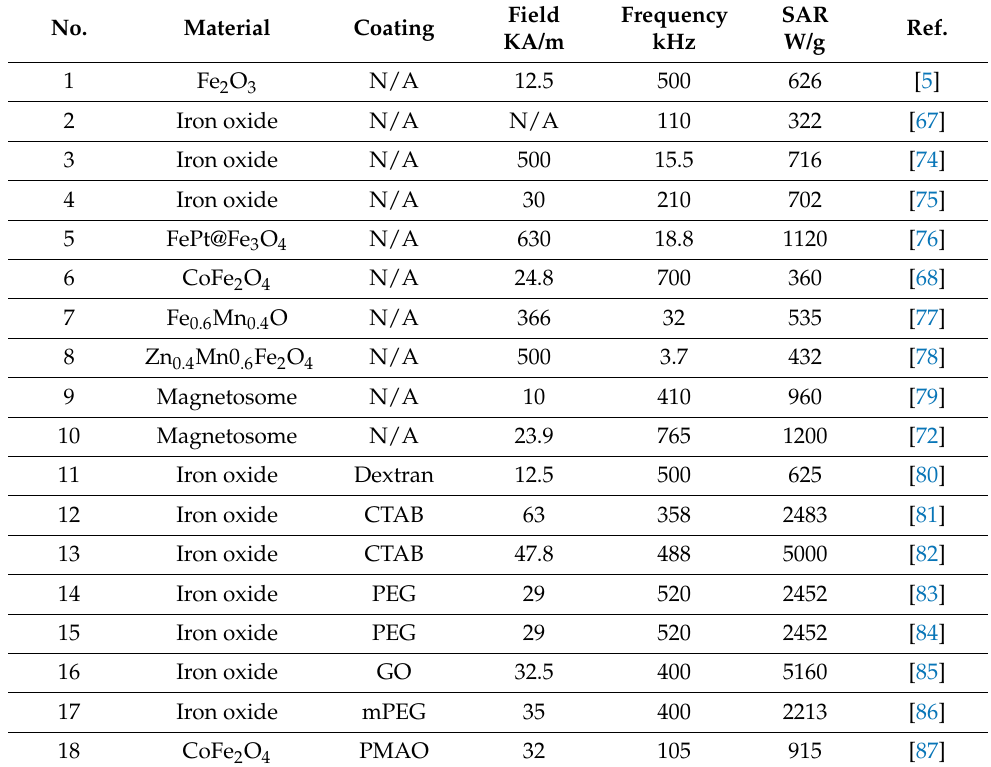
Table 1. SAR values for MNPs from the